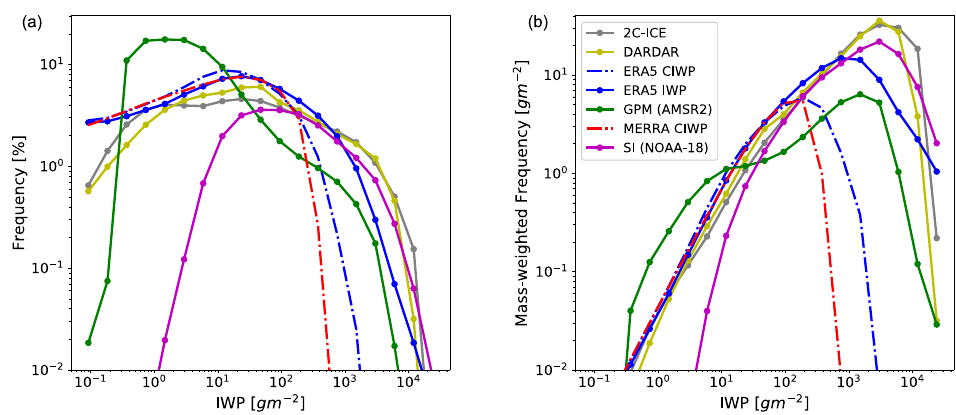
Figure 2. Probability distribution function of IWP values from native resolution level 2 data and 0.5 ◦ reanalysis data. This is shown as a per- centage (a) and weighted by mass (b) ; i.e. summing values in the right panel yields approximately the near-global mean. These data include daytime values spanning 60 ◦ N–60 ◦ S from 2015, with 2C-ICE (2008) and SI (2013) being the exceptions due to availability. DARDAR data were treated with a running mean of 6 pixels to approximate a passive microwave footprint. The frequencies shown account for zero values, which are given in the